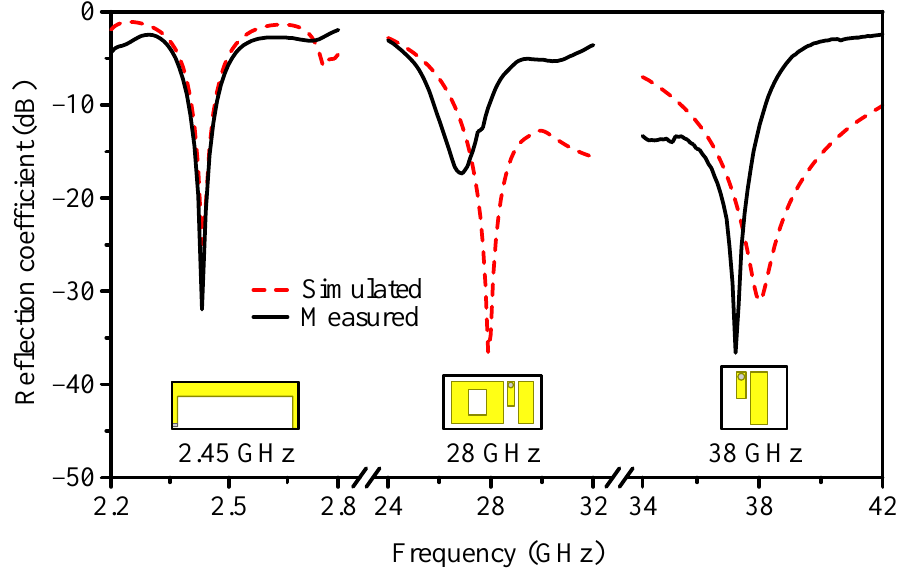
Figure 6. Reflection coefficients for the 28 GHz unit element, 38 GHz unit element, and 2.45 GHz loop antenna.